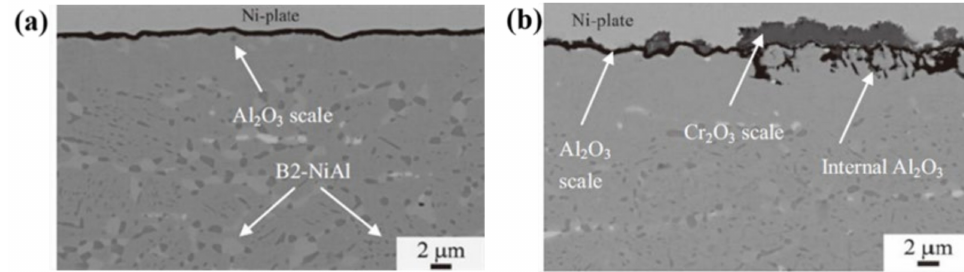
Figure 8. Oxidation scale of AFA steels: ( a ) single thin scale; ( b ) complex oxide scale